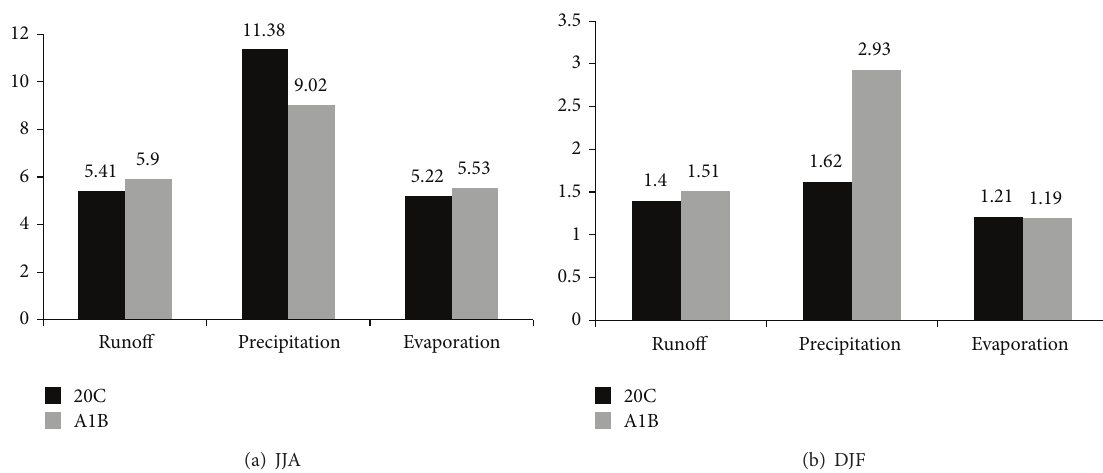
Figure 5: Seasonally averaged runoff, precipitation, and evaporation (mm d −1 ) for (a) JJA and (b) DJF over land of Korea.